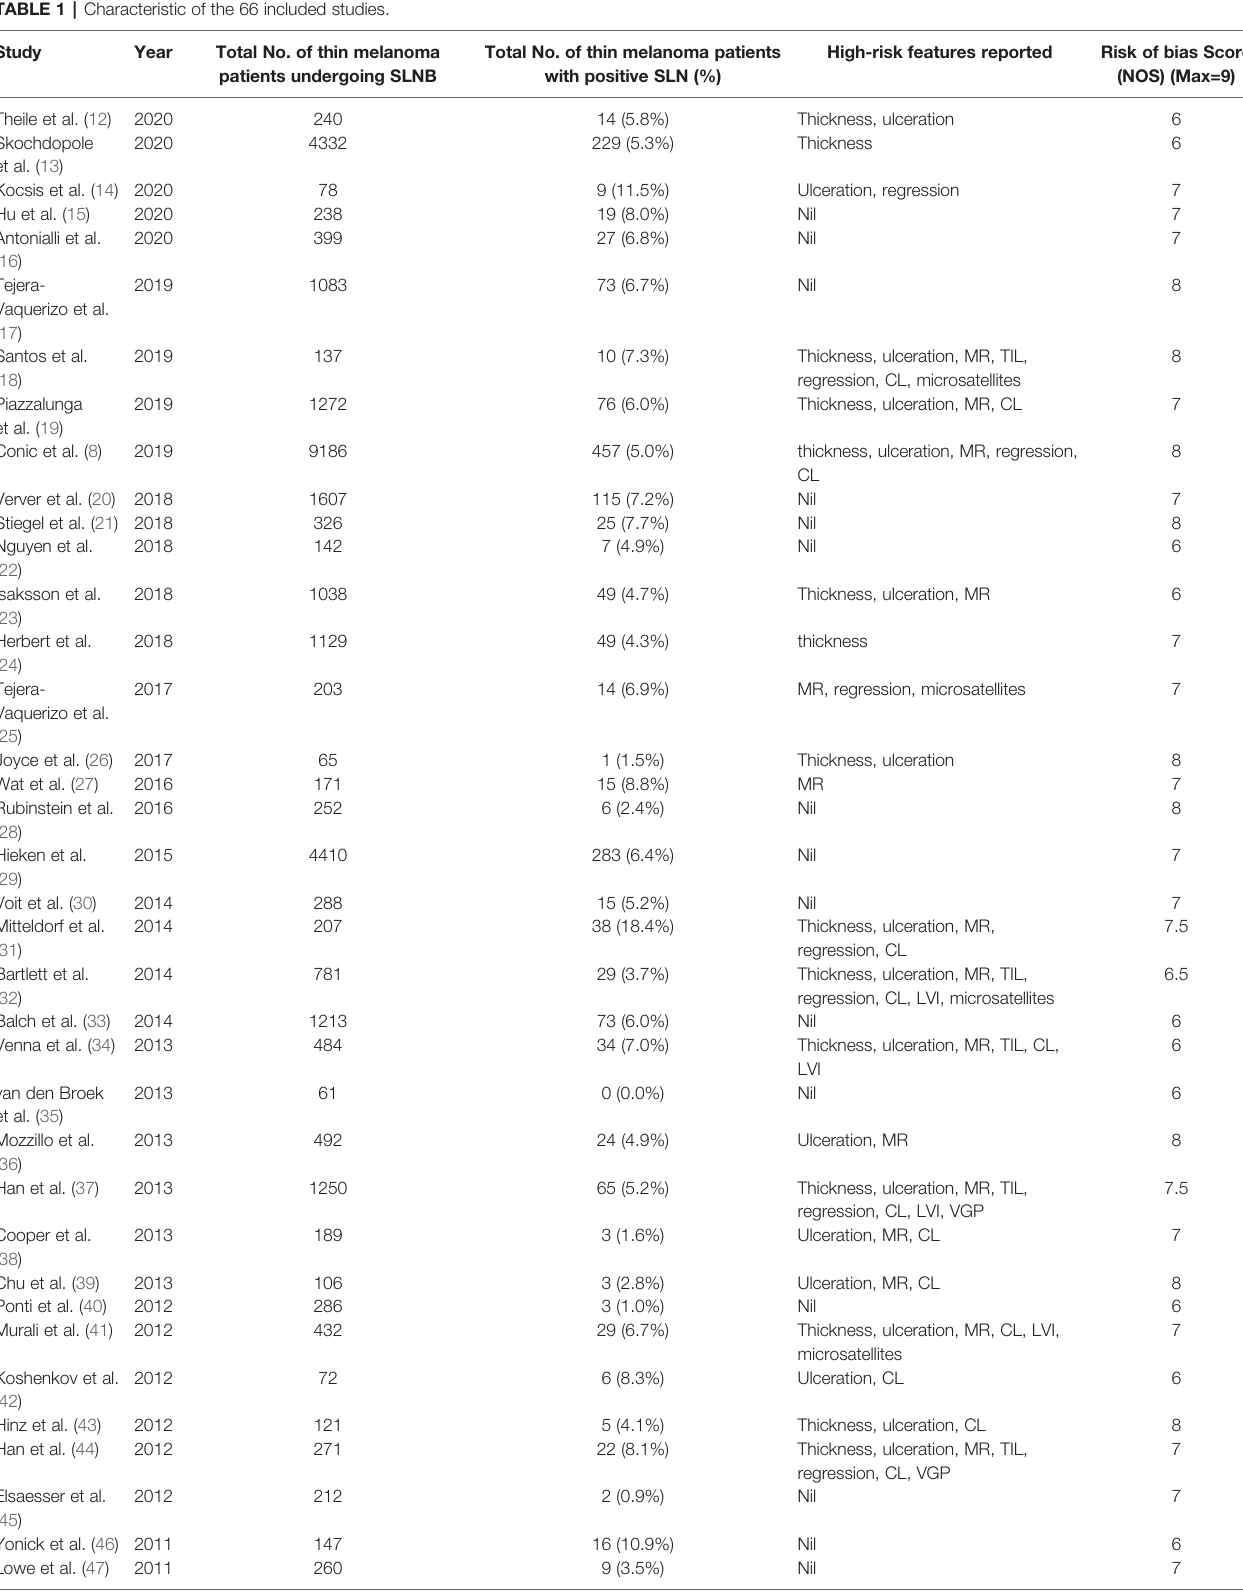
TABLE 1 | Characteristic of the 66 included